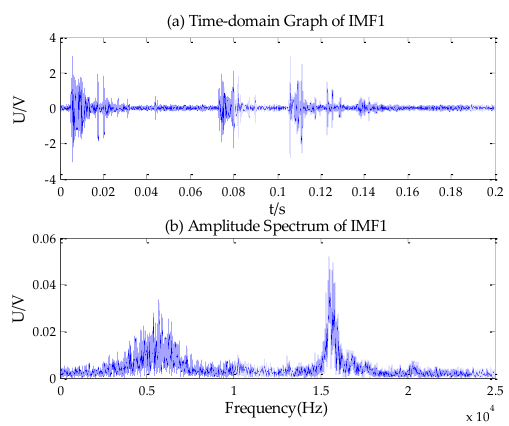
Figure 8. Empirical mode decomposition (EMD) decomposition result.